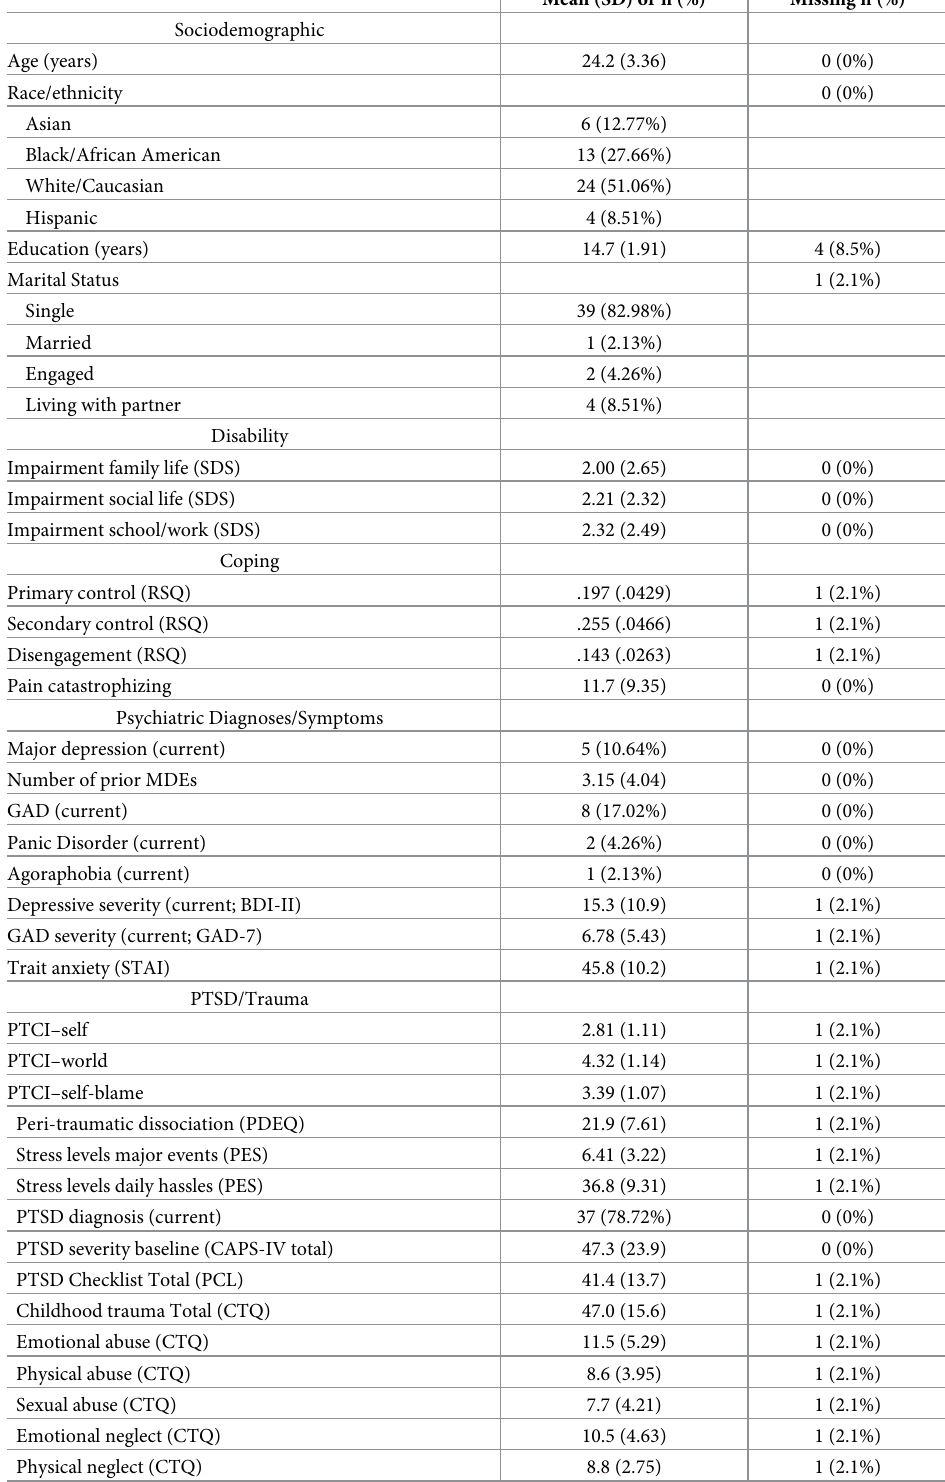
Table 1. Descriptive and clinical characteristics and missing data of recent interpersonal violence